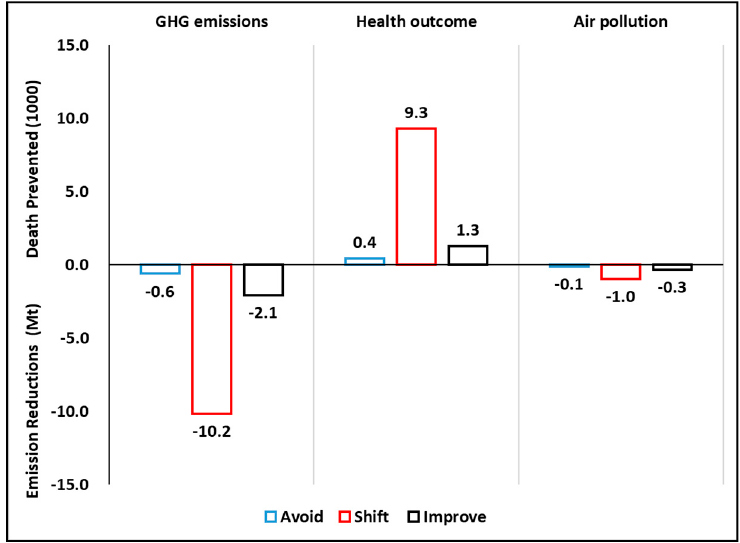
Figure 9. Expected co-benefits from each action in the TTMP.